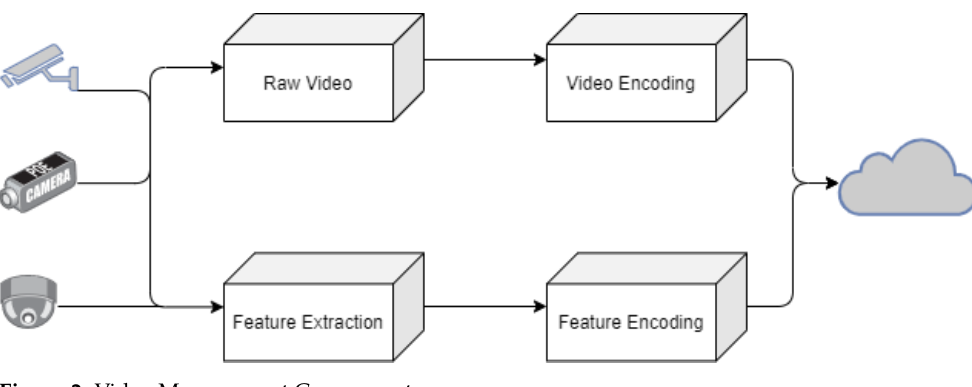
Figure 2. Video Management